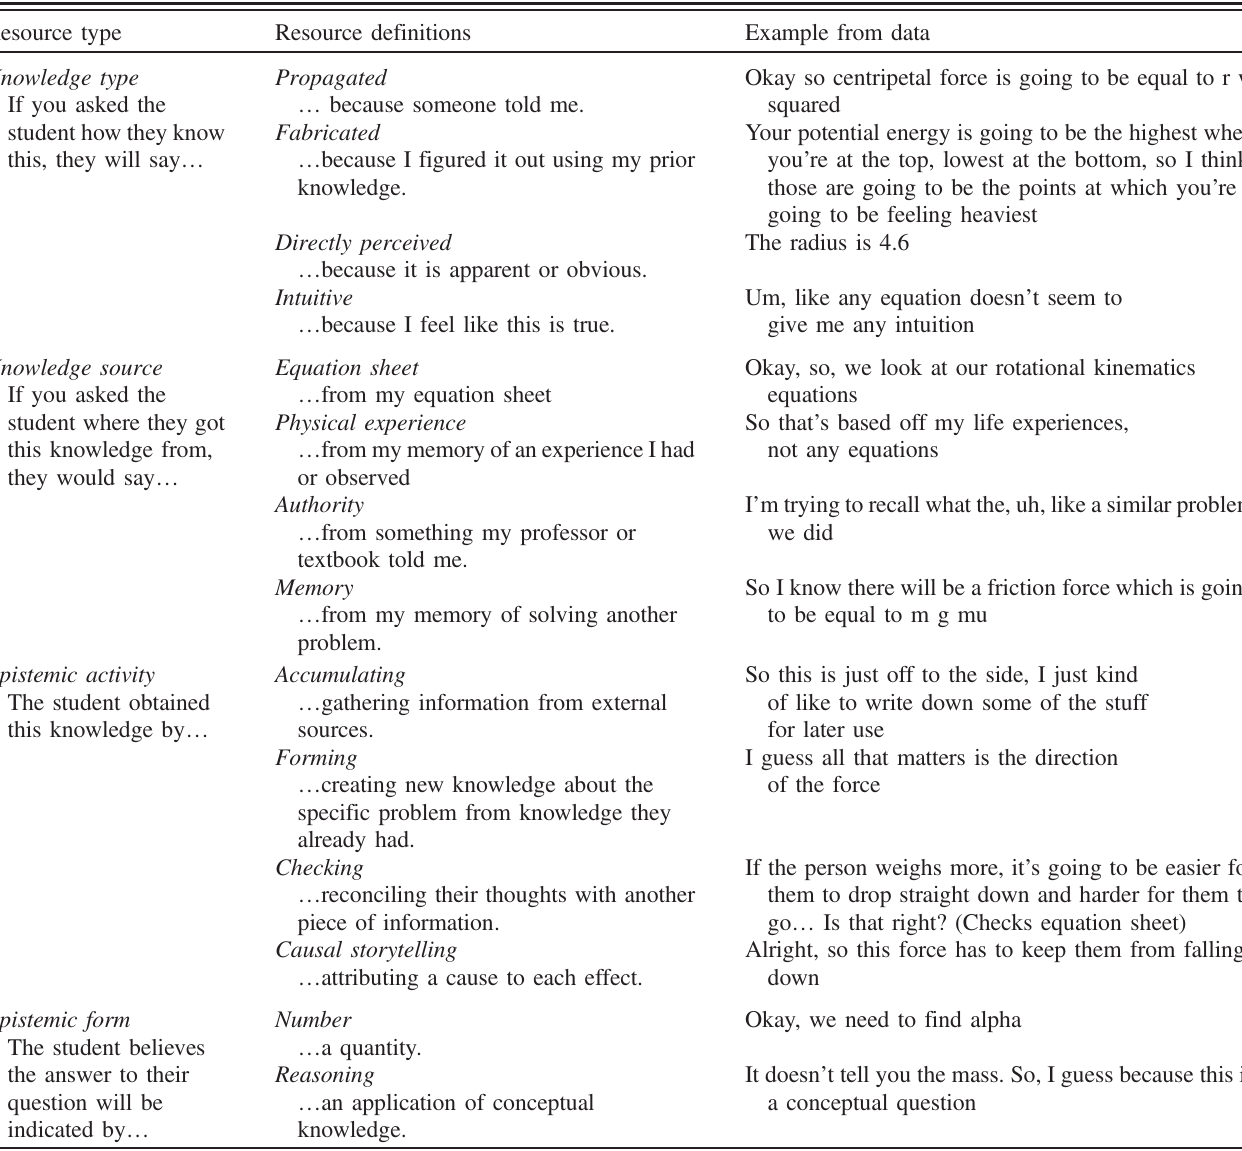
TABLE I. Definitions used for each epistemological resource. Resource